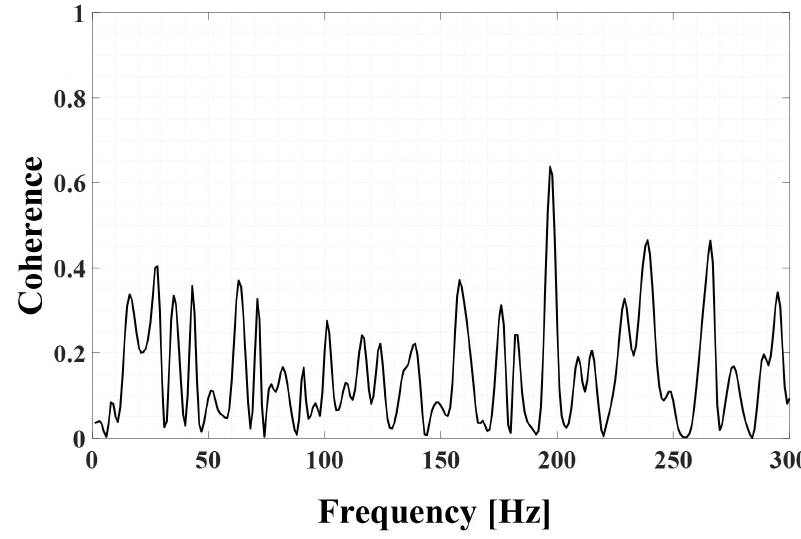
Figure 6. Coherence results calculated using transient signals.